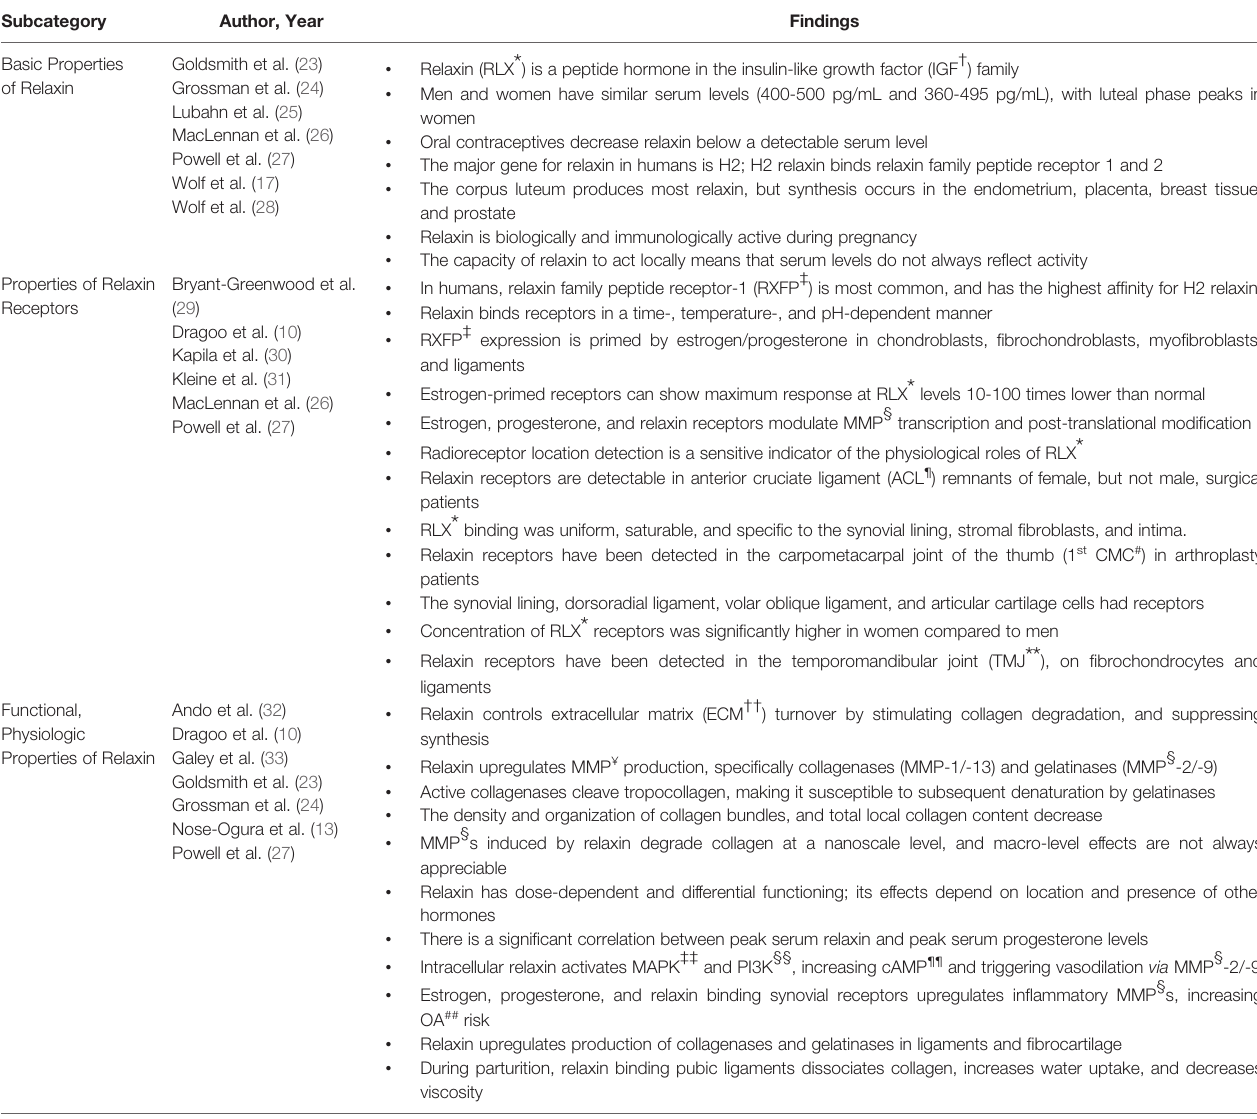
TABLE 2 | Cellular/molecular effects of relaxin- relevant literature fi